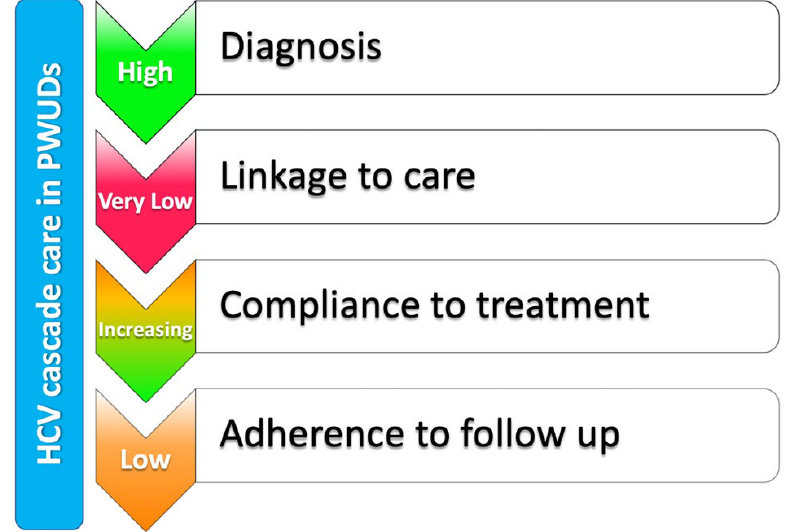
Figure 1. HCV care cascade in the PWUDs population: lights and shadows.